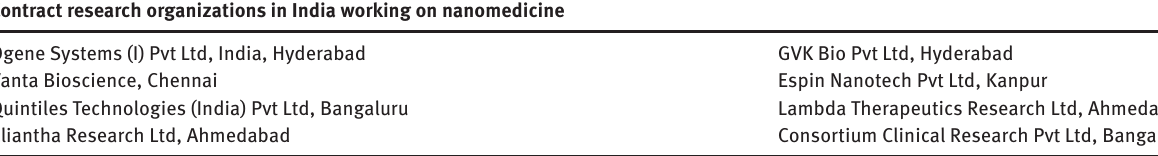
Table 6: A list of CROs operating in India in nanomedicine (source: compiled by authors by survey and from different websites).